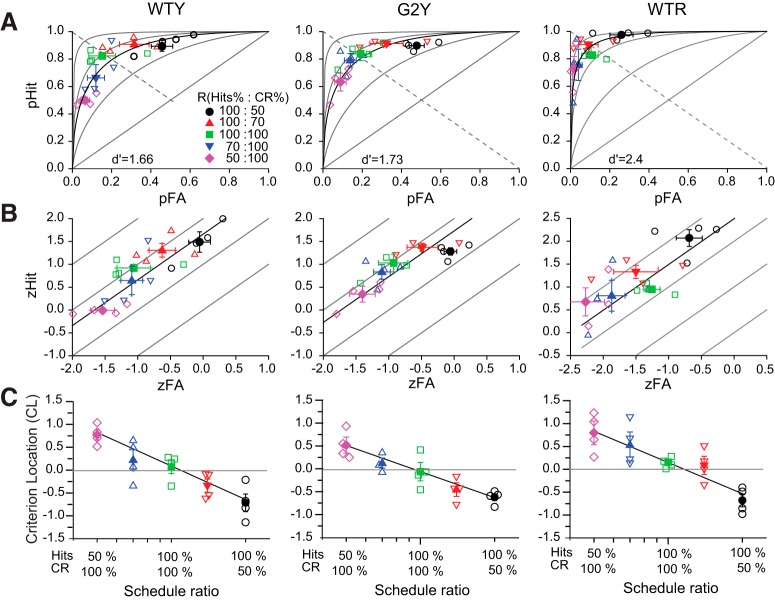
d´ is a bias-free measure of temporal contrast sensitivity in mice. A, ROCs implied by d´ can predict empirical data. Empirical ROC curves of three mice (two WT mice and one GNAT2cpfl3 mouse labeled WTY, WTR, and G2Y, respectively) determined by varying the reward schedules. Mice were first tested with 100%:100% reward schedules, and successively with 100%:70% and 100%:50% reward schedules, or alternatively, with 70%:100% and 50%:100% reward schedules. Open symbols indicate daily pHit and pFA pair values, closed symbols represent the average ± SEM, n = 5-6 trials. The data are well fit by the model: d´ = z(pHit) − z(pFA), where z(pHit) and z(pFA) are the z score values (in SD units) of pHits and pFA. Model predictions are illustrated by the continuous ROCs with maximum likelihood predicted d´ values of 1.66 (WTY), 2.49 (WTR), and 1.73 (G2Y; Table 2). For reference, ROCs for d´ = 0, 1, 2, and 3 are indicated in gray. B, Same as in A, but plotted on z-coordinates. Note that in these coordinates the ROCs have unitary slopes, which is consistent with the notion that d´ sensitivity estimates do not depend on the location of the decision criteria (Macmillan and Creelman, 2005). C, CL derived from the empirical ROC curves decreases linearly with the logarithm of the reward schedule ratio. Continuous black lines indicate regression fits (R
2 > 0.9) with Equation 5, and q values of 1.75 (WTY), 2.4 (WTR), and 1.4 (G2Y).